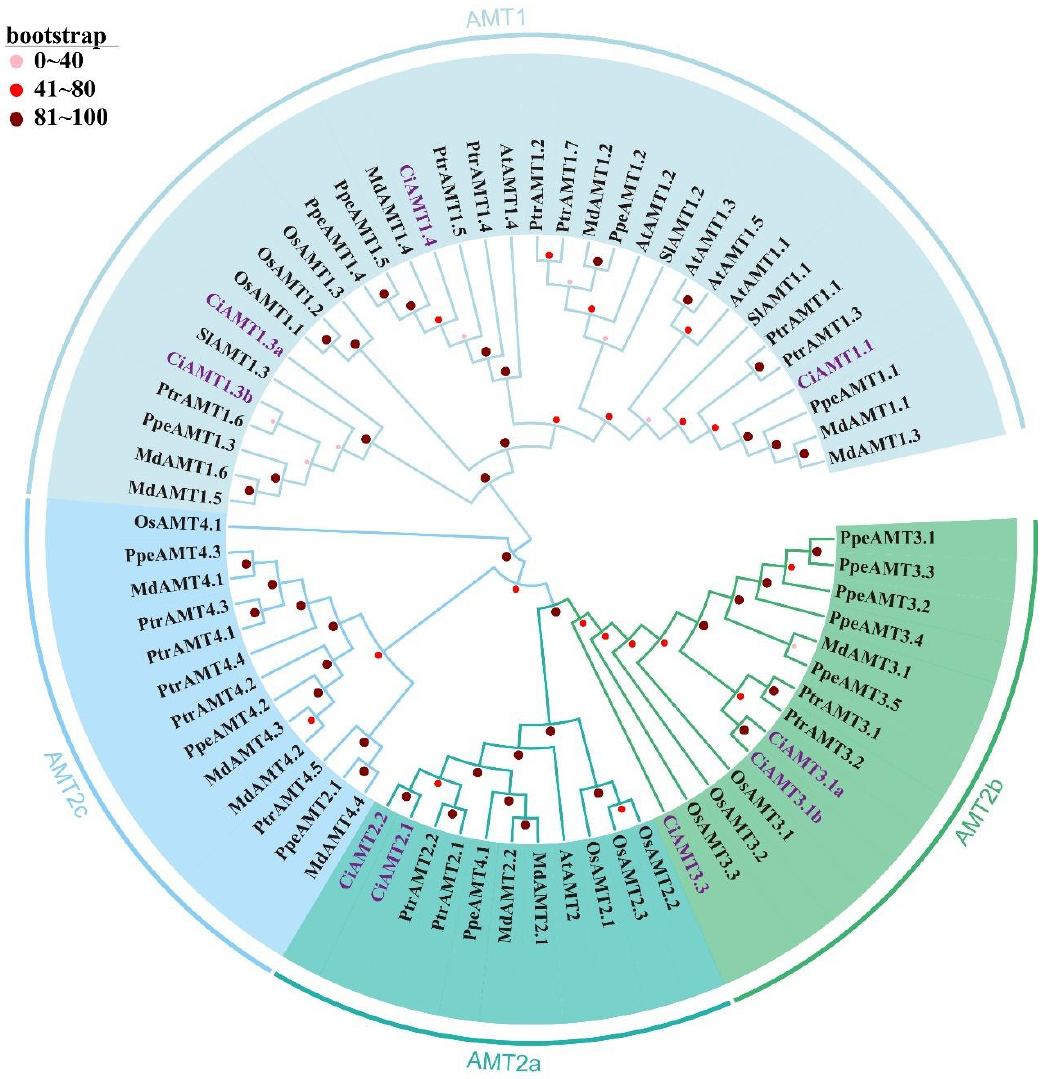
Figure 1. Phylogenetic analysis of AMT gene family in pecan ( Carya illinoinensis ), poplar ( Populus trichocarpa ), apple ( Malus domestica ), peach ( Amygdalus persica L.), tomato ( Lycopersicon esculentum Miller), rice ( Oryza sativa L.) and Arabidopsis ( Arabidopsis thaliana ). AMT proteins from seven species were divided into two subfamilies (AMT1 and AMT2). The AMT2 was further divided into three clusters (AMT2a, AMT2b, and AMT2c).